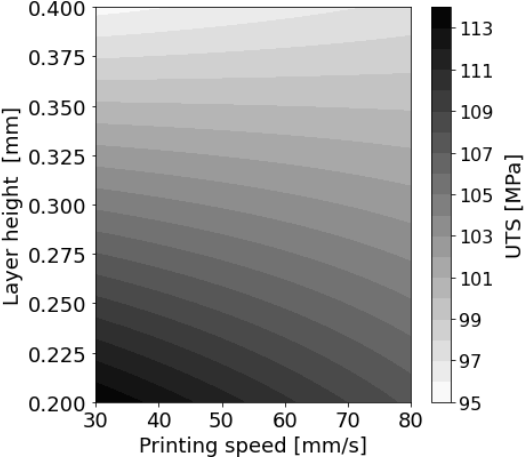
Figure A6. Contour plot for v and h based on DoE prediction model.